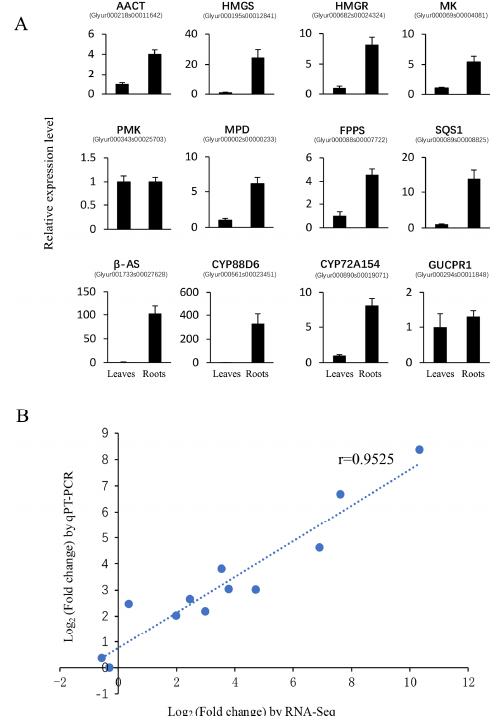
Figure 2. qRT-PCR validation of structural genes ( A ) and the correlation between qPT-PCR and RNA-Seq results ( B ). In Figure 2 (A), the expression level of the structural gene in the leaves was set to 1, the relative expression of genes in roots was calculated, and the error bar is shown. In Figure 2 (B), the X -axis represents the log2 (fold change) of the RNA-Seq results, and the Y -axis is the log2 (fold change) of the qRT-PCR